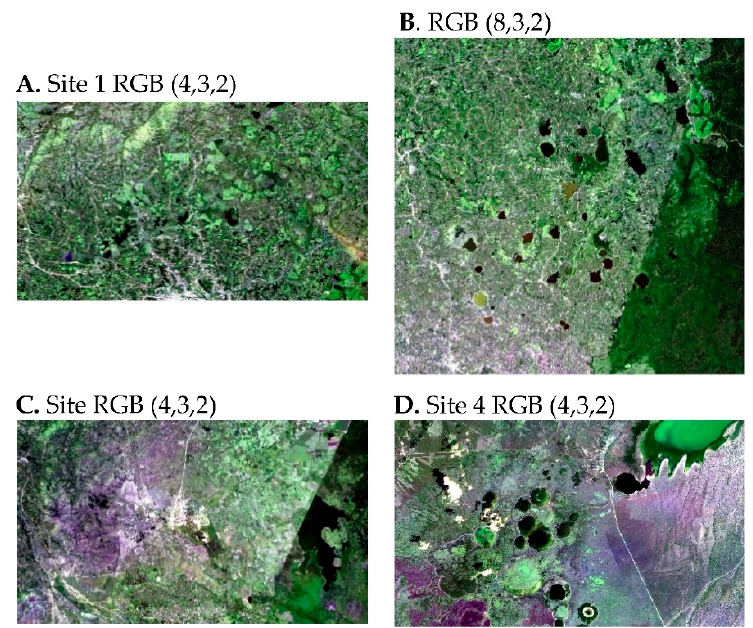
Figure 3. Sentinel-2 MSI RGB (4,3,2) 10 m natural-color images of the studied sites. Frames ( A – D ) are studied sites 1, 2, 3, and 4, respectively.